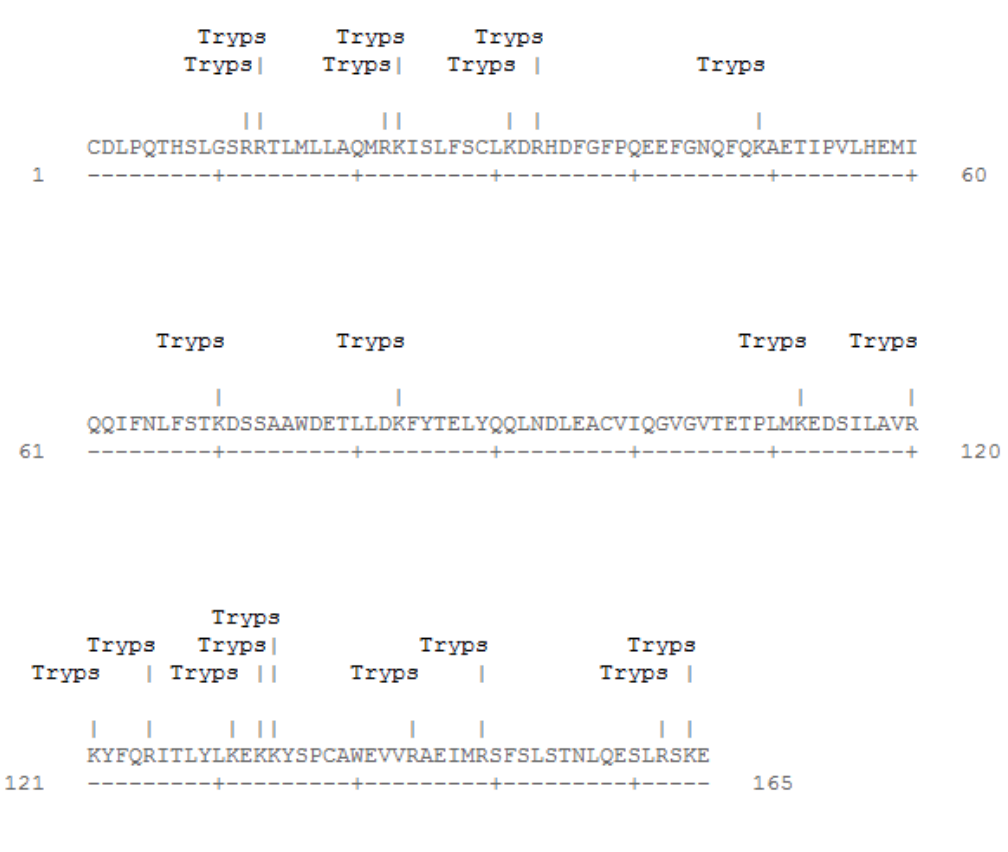
Figure 3. Amino acid sequence determination by MALDI TOF TOF and proteolytic cleavage site of trypsin in hIFNα-2b by using peptide cutter (Expasy). The identified residues were shown in